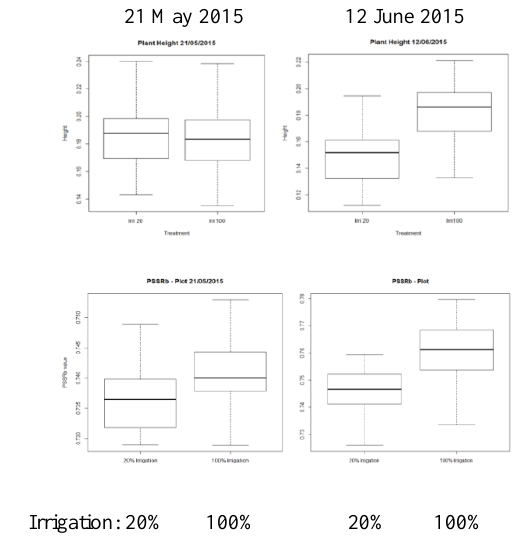
Figure 5. Boxplots showing the variation in average plant height and PSSRb per plot for each irrigation treatment on two flight